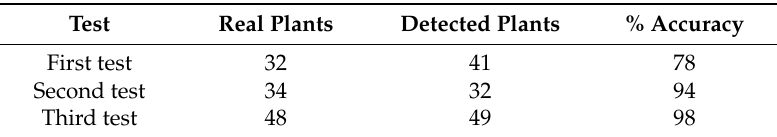
Table 6. Plant detection ratio in field trials.